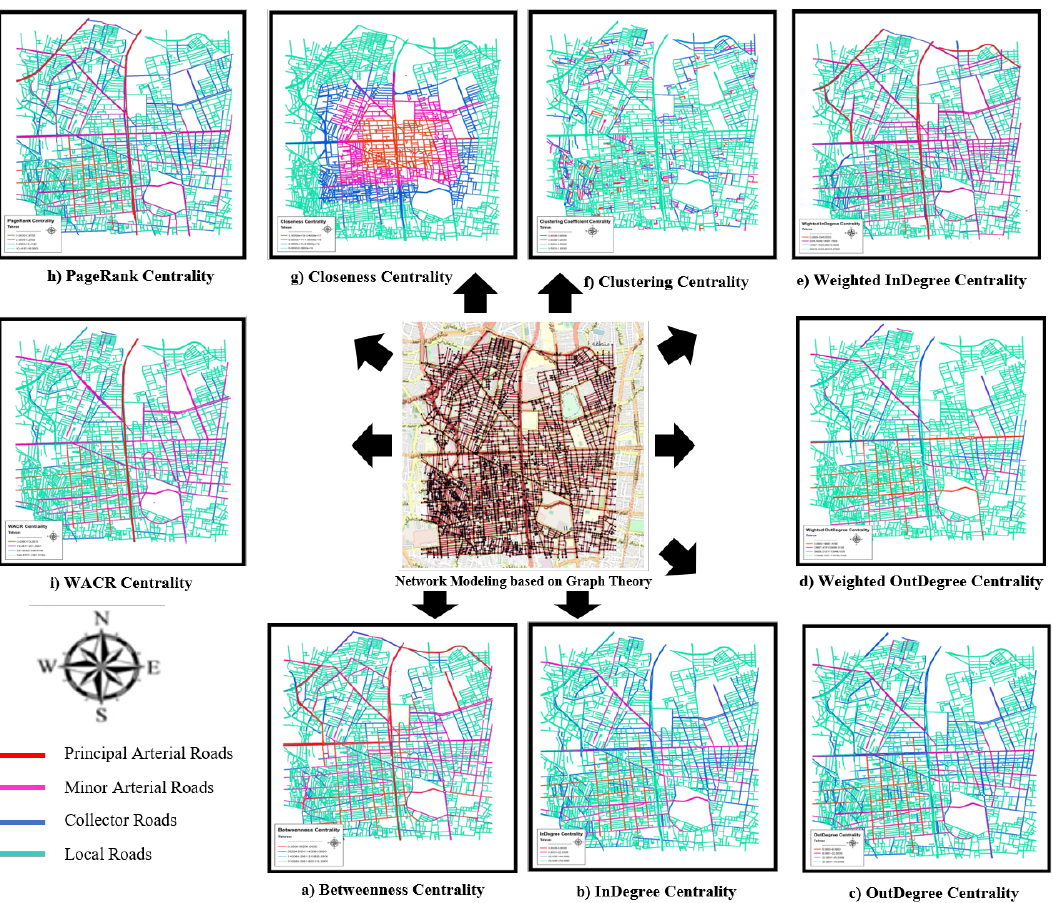
Figure 3. All nine centrality measures generated for Tehran,